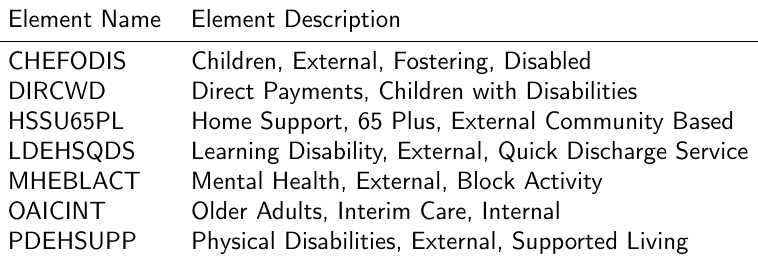
Table 2: Sample service elements and their description.